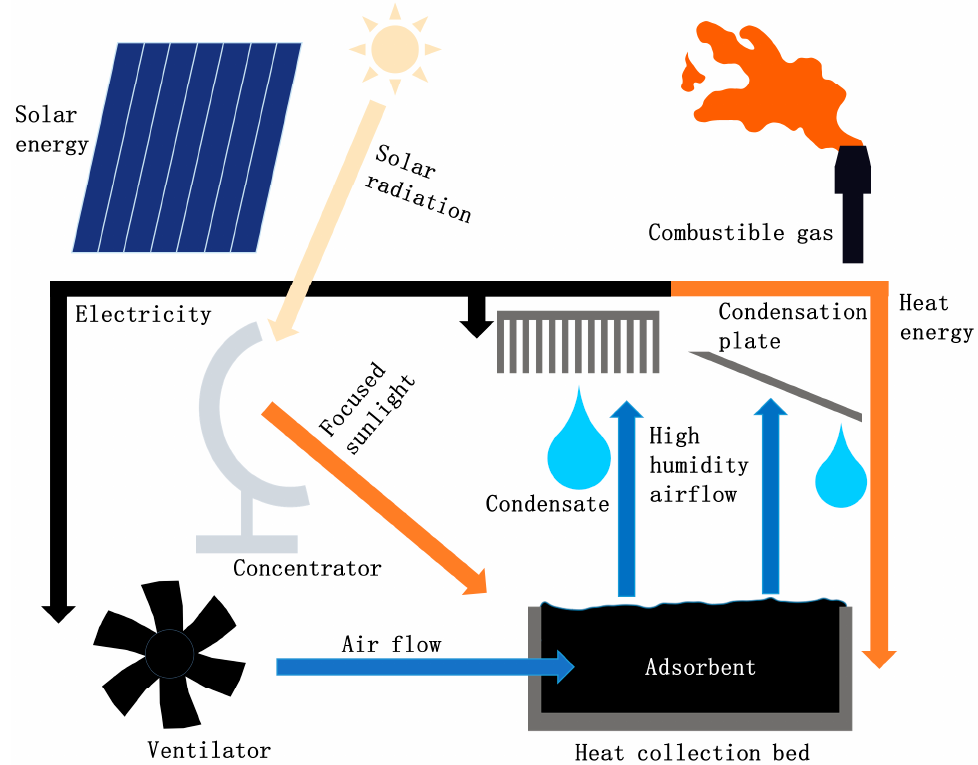
Figure 5. Schematic diagram of atmospheric water harvesting systems based on adsorption/ Figure 5. schematic diagram of atmospheric water harvesting systems based on adsorption/desorp- desorption tion cycles.